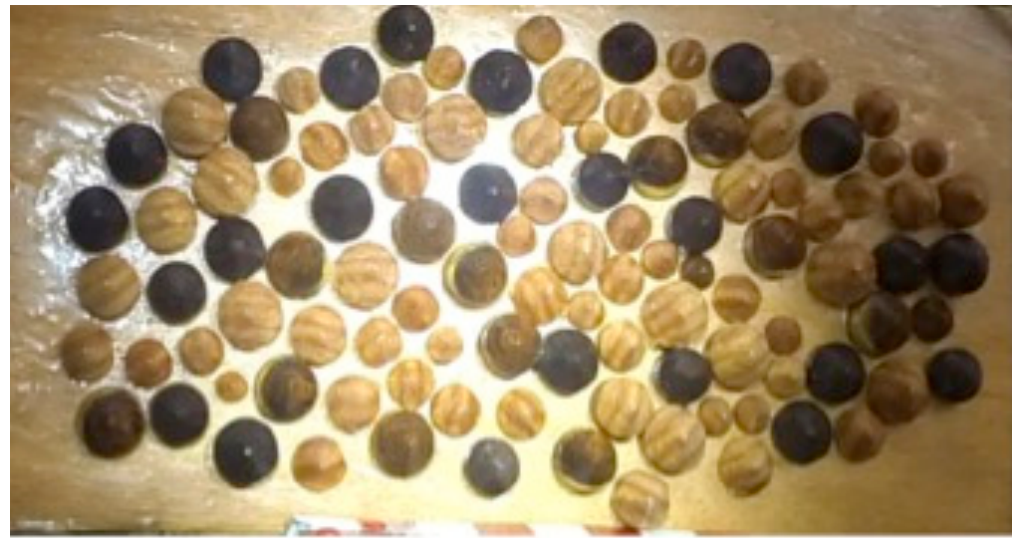
Figure 3. Close-up view of the artificial colonization and board.